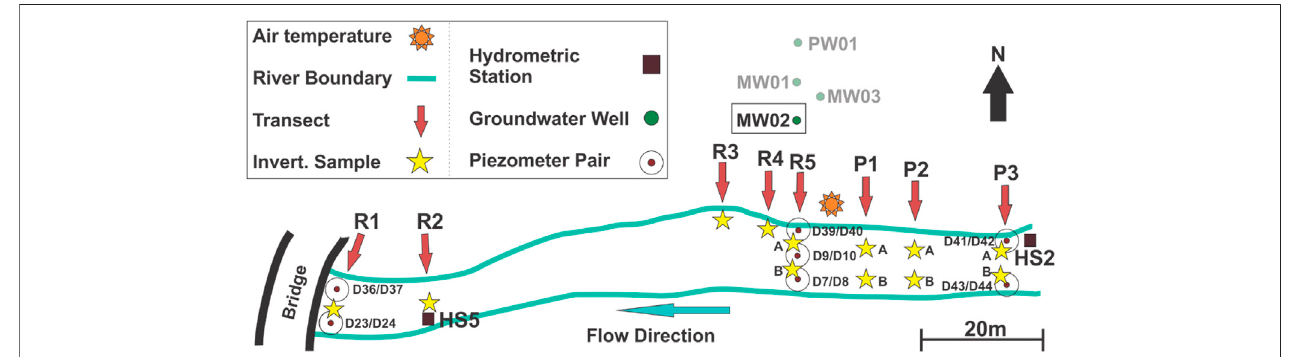
FIGURE 3 | Hydrological monitoring network at the Otter Park fi eld site showing the con fi guration and locations of macroinvertebrate and habitat sampling sites. The macroinvertebrate sampling sites (yellow stars) are numbered the same as the fl ow transects (red arrows). Where there are two macroinvertebrate sampling sites along a fl ow transect, the north location is A and the south location is B. Stream width is representative of wetted width in